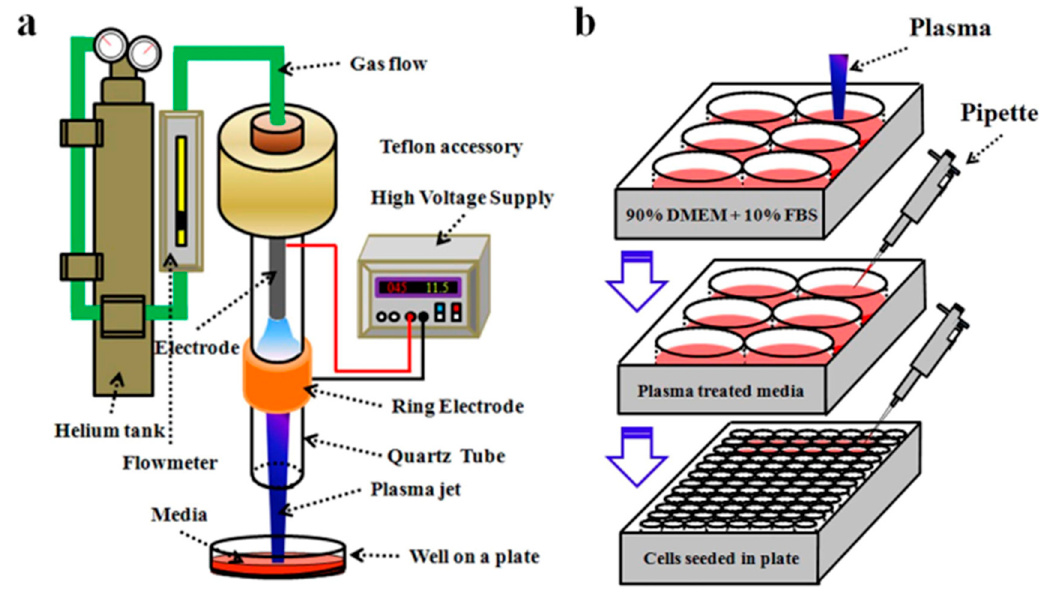
Figure 2. Schematic diagram showing the two methods of plasma treatment. ( a ) Direct treatment on cells with media and also depicts the general plasma generation process. Helium gas acts as a carrier gas for continuous generation of plasma (green line). Plasma (blue line) is generated in between the two electrodes by the application of high voltage. The generated plasma jet can directly be exposed to the cell culture vessels; ( b ) Exposure of cells into plasma treated media. (Dulbecco’s Modified Eagles Medium (DMEM) is cell culture medium used in conjugation with Fetal Bovine Serum (FBS)).